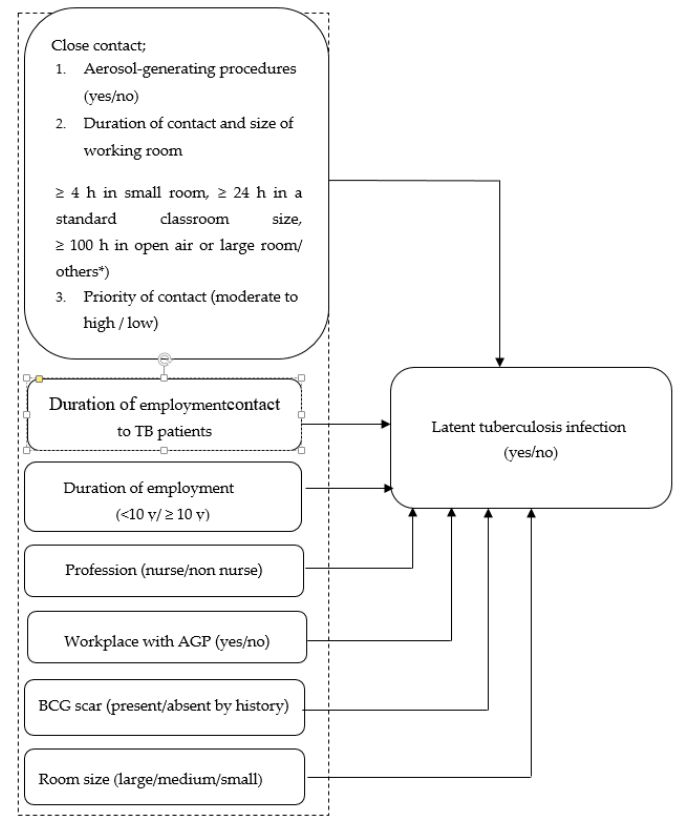
Figure 1. Conceptual framework of risk factors of LTBI in HCWs. * Others meant an HCW exposed to TB patients for a duration and in a working room not already defined in the assigned categories.